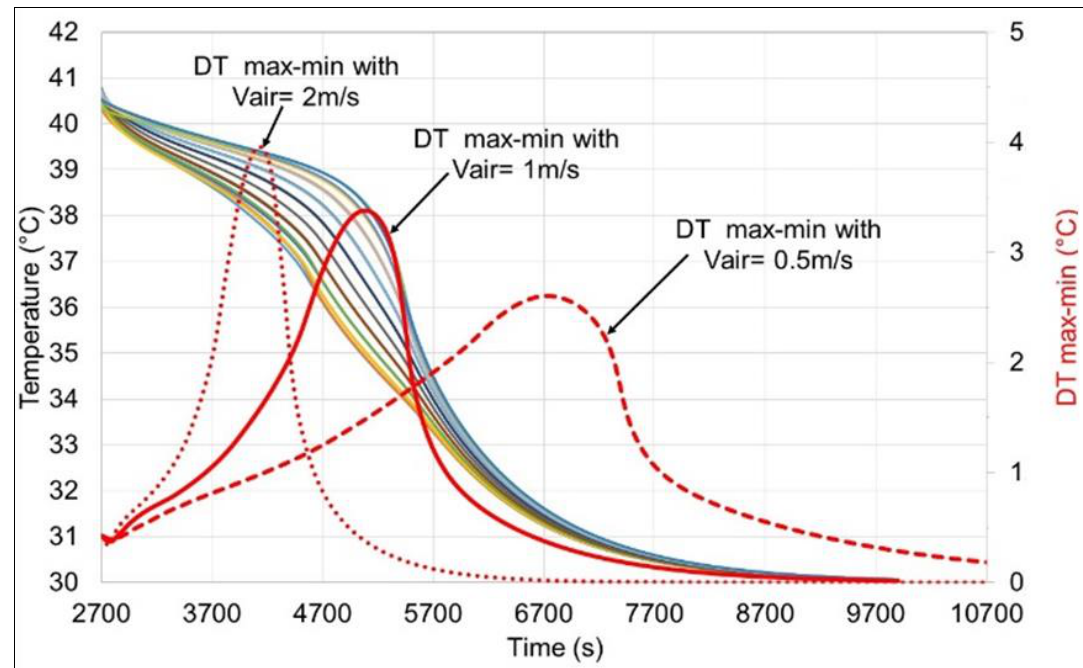
Figure 20. Temperature of the cells calculated by the CFD model when the battery pack is cooled down by an airflow characterized by V air = 1 m/s and there is no thermal dissipation from the cells. Trend of DT max-min from CFD simulations for an airflow with Vair = 0.5, 1 and 2 m/s.